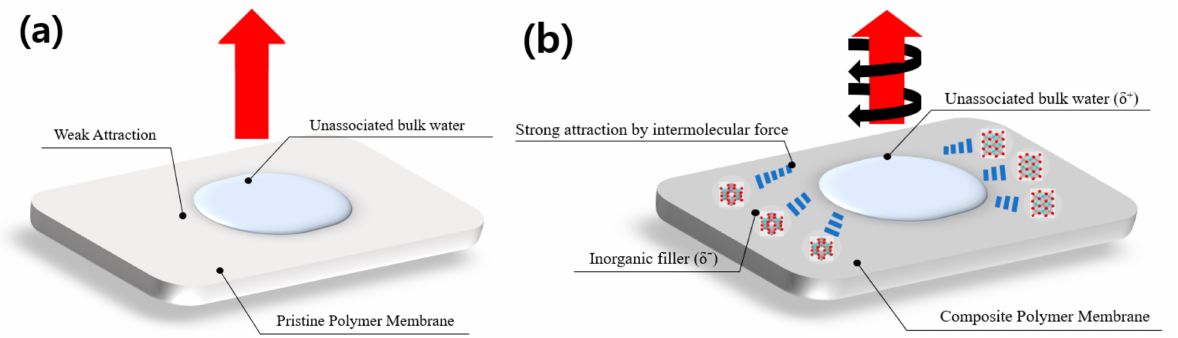
Figure 6. ( a ) Comparison of pristine polymer membrane and ( b ) composite polymer membrane with inorganic nanoparticles regarding an intermolecular